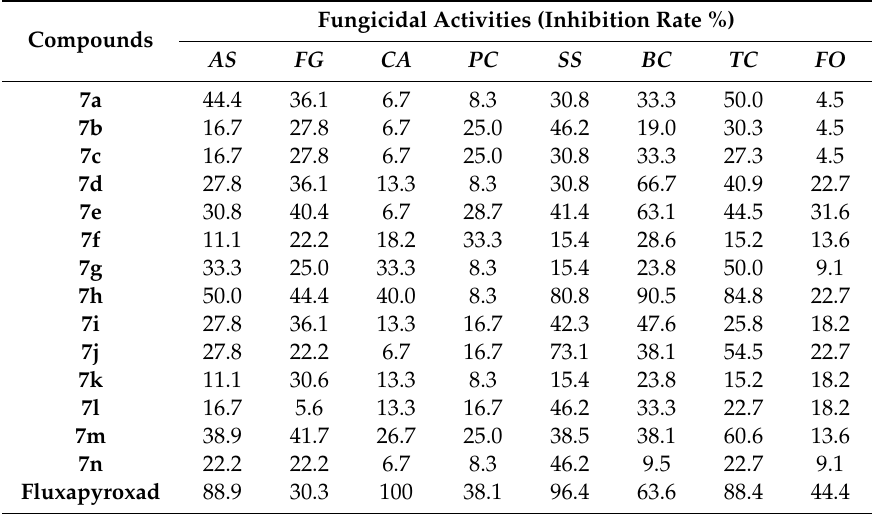
Table 4. Fungicidal activities of title compounds 7a – 7n at 50 mg / L. Compounds